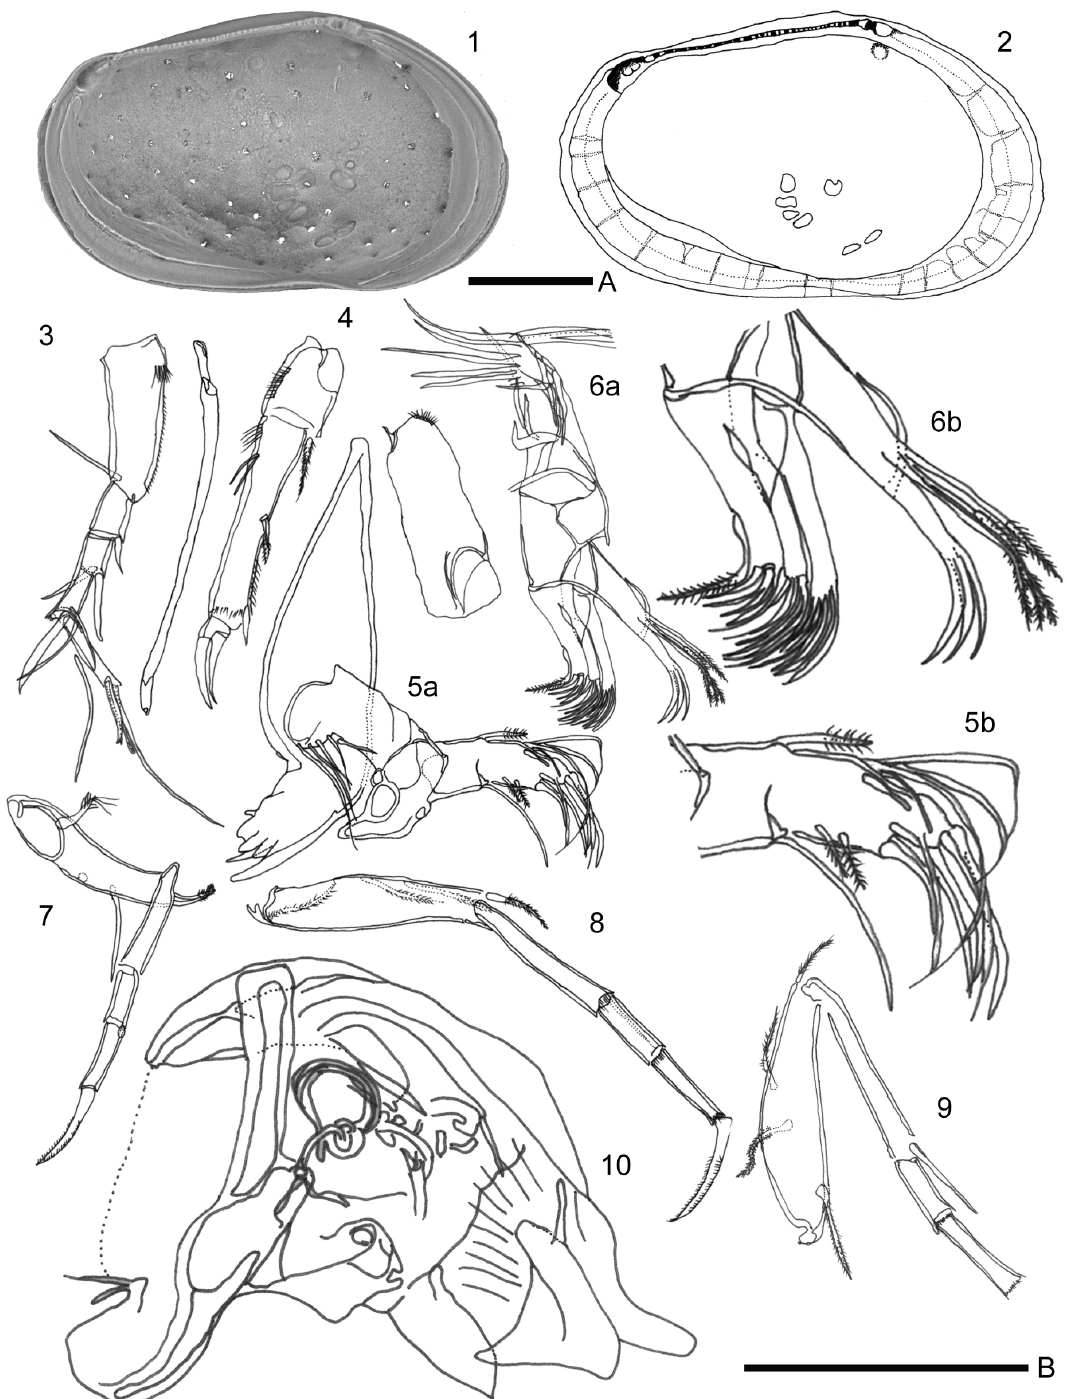
Figure 7. The valve and the soft parts of Loxoconcha cotoensis sp. nov. (1–2) internal view of female left valve (VNMN.0103); (1) scanning electron photomicrographs; (2) camera lucida drawing; (3–10) camera lucida drawing of soft parts of the male – (3) antennule; (4) antenna; (6b) distal part of maxillula; (7) first thoracic leg; (8) second thoracic leg; (9) third thoracic leg; (10) copulatory organ (VNMN.0104, 0105, 0106). Scale A, 100µm for 1–2; scale B, 100µm for